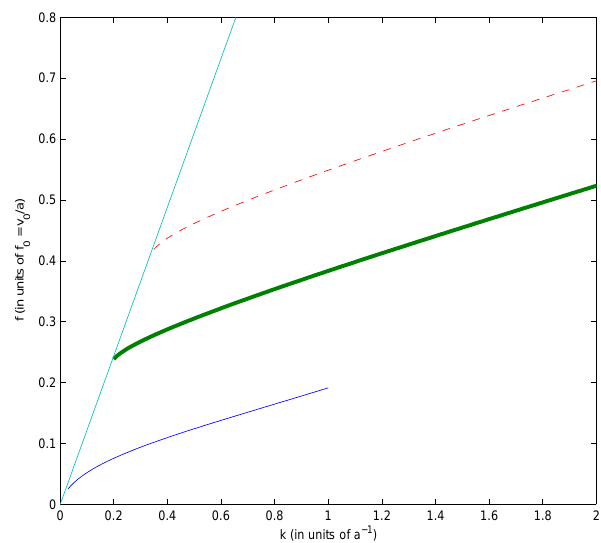
Fig. 1. Dispersion curve for the evanescent MHD eigenmodes of a Harris sheet. Frequency in units of v A /a is plotted against the wave number in units of a − 1 . Thin and dashed lines are the first and second kink mode. Thick line is the first sausage mode. All the dispersion curves stem from the f = kv A , lobes /( 2 π) line with v A , lobes = 7 . 4 v A is the Alfv´en velocity in the